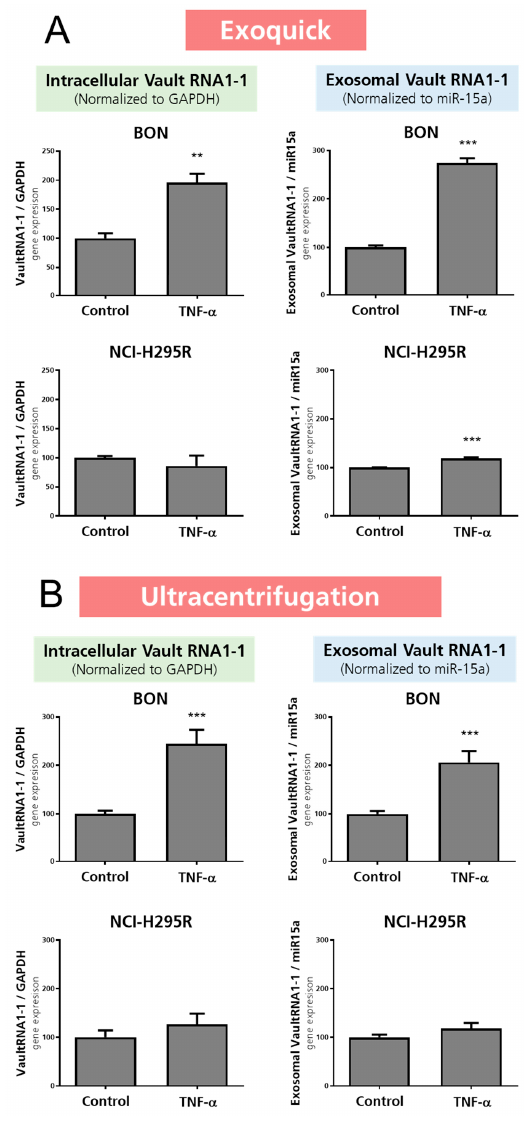
Figure 3. Intracellular and exosomally loaded vault RNA1-1 from cells and cell culture supernatants of TNF α -treated BON and NCI-H295R cells. Exosomes were either isolated by ExoQuick ( A ) or ultracentrifugation ( B ). The statistical significance is based on paired t -tests vs. controls and is denoted as stars (** p < 0.01; *** p < 0.001).